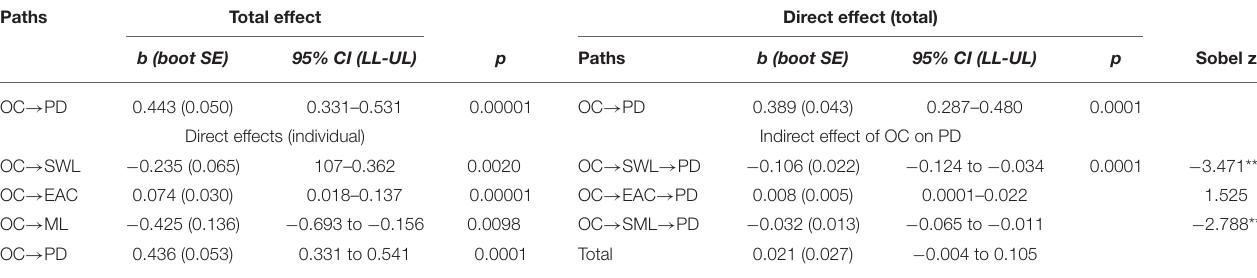
TABLE 2 | Standardized indirect, direct effects and total effects of obsession about COVID-19 on psychological distress in parallel mediation model (Model 4). Paths